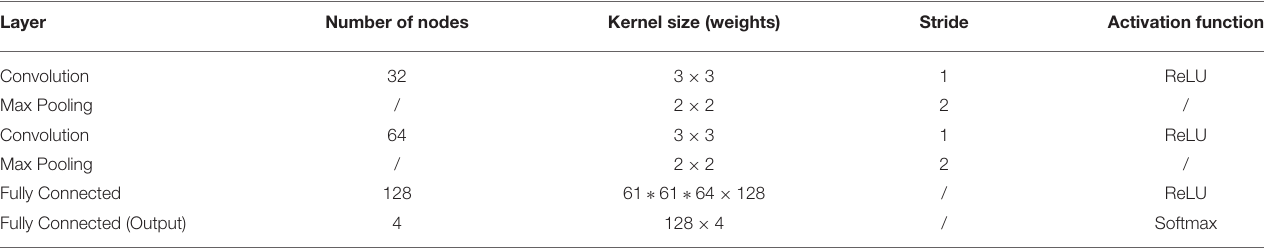
FIGURE 1 | Layout of CNN created, including two convolutional and max pooling layers and two fully connected layers. The first convolutional layer has 32 channels followed by max pooling layer and the second convolutional layer has 64 channels followed by a max pooling layer. The fully connected layer has 128 nodes and then the final fully connected layer has four nodes which correspond to each of the classes—Quiet Sun, two-ribbon flares, limb flares, and circular/compact flares.